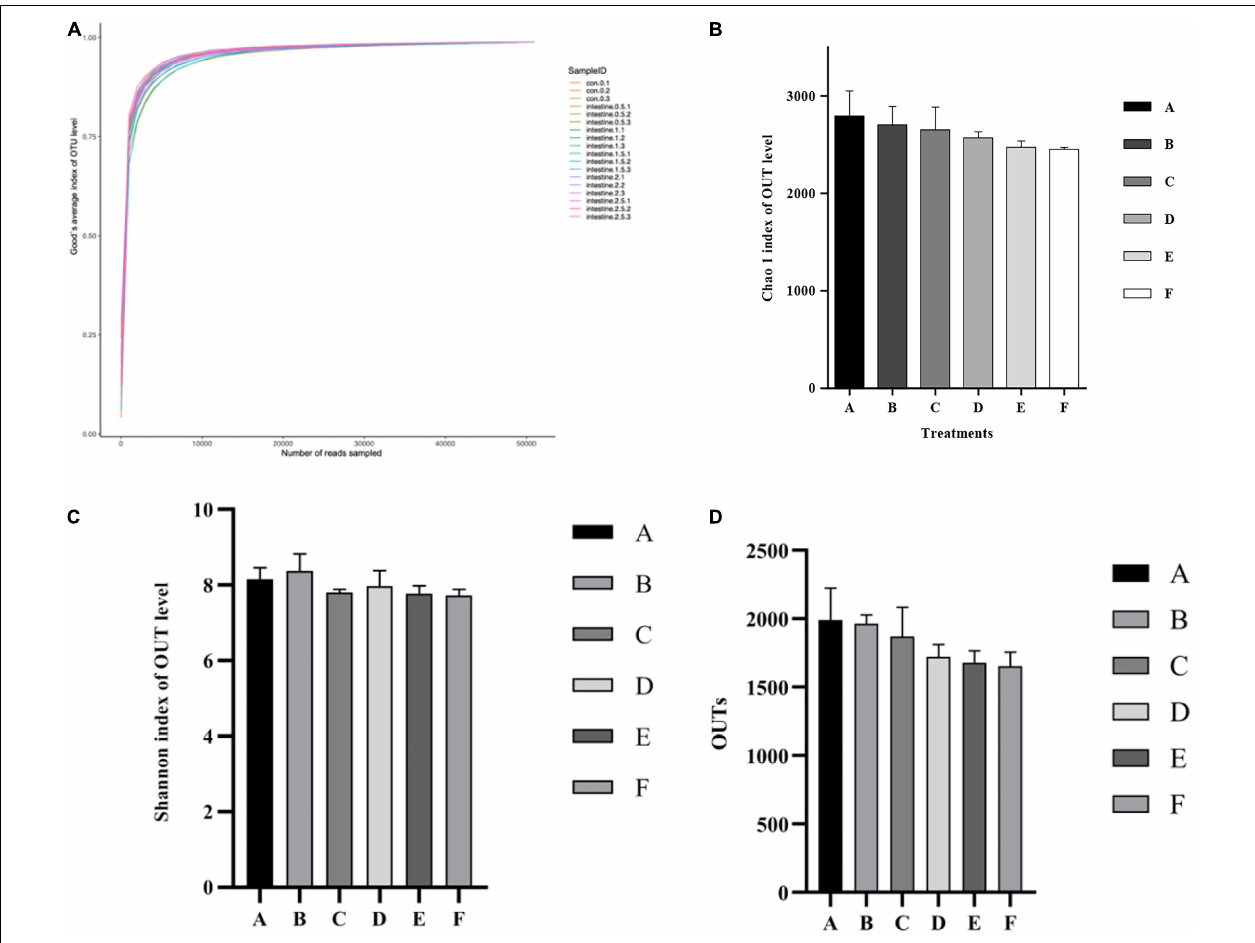
FIGURE 3 | Analysis of alpha diversity comparisons with the microbial communities in intestine of shrimp fed with different astaxanthin levels for 56 days. (A) Good’s coverage curve; (B) Chao species richness index; (C) Shannon’s diversity index; (D) OTUs richness comparison index for A, B, C, D, E, and F intestinal samples. Data are expressed as mean ± SEM from triplicate groups. Different letters indicate significant ( p < 0.05) differences among various bars. OTUs, operational taxonomic